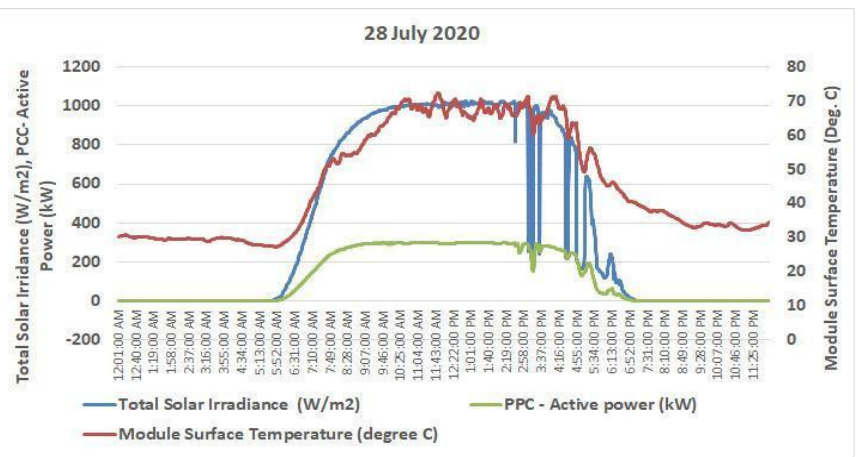
Figure 15. Variation of active power with temperature and irradiance on a partially cloudy day with a very high temperature.